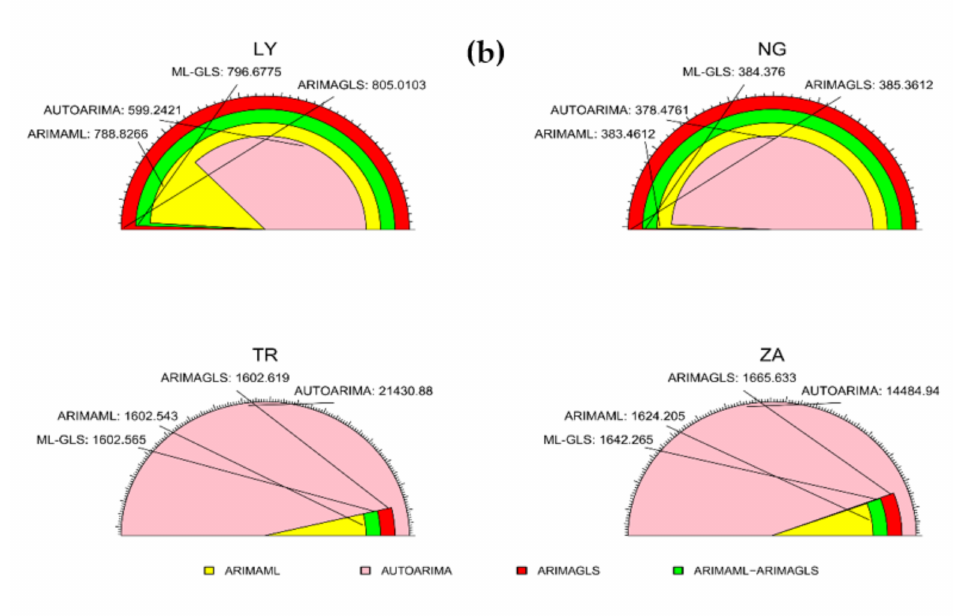
Figure 13. Fan plot of RMSE for the: ( a ) training, and ( b ) testing samples.